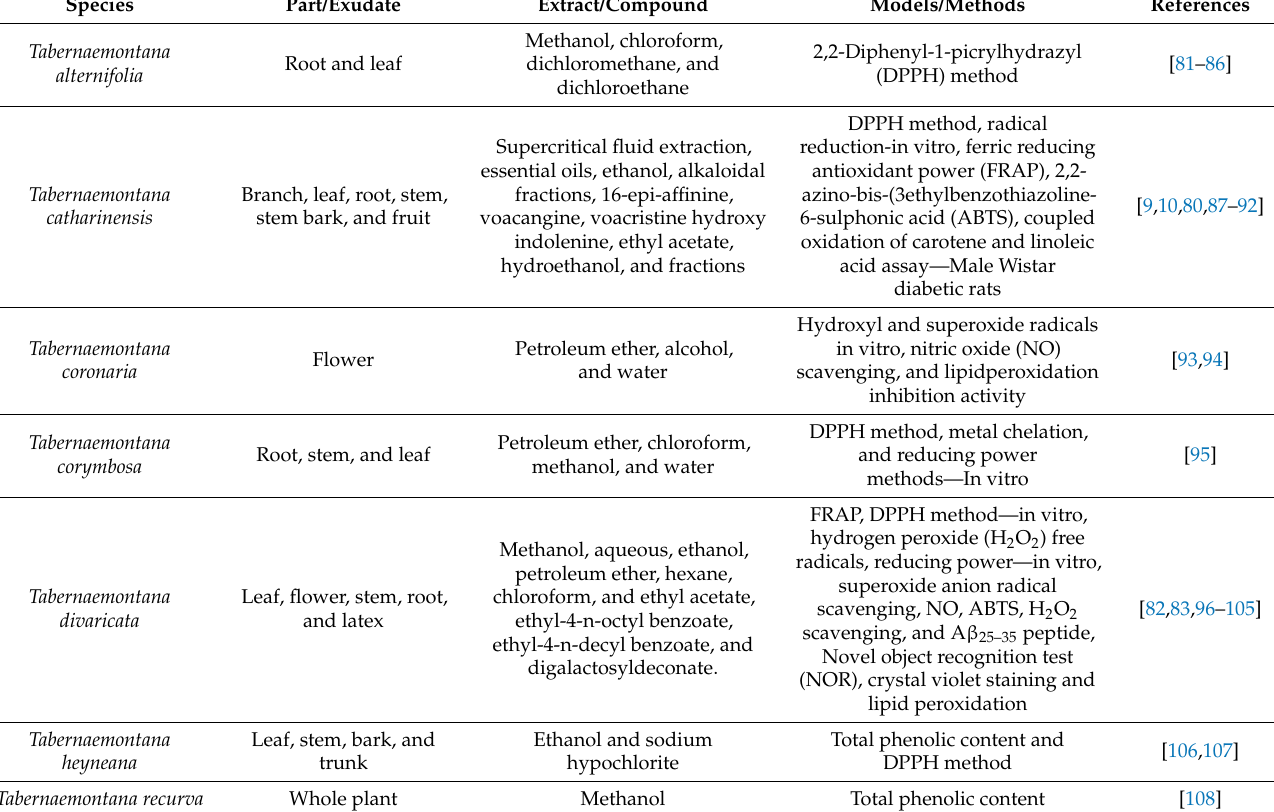
Table 2. Antioxidant activities of extracts and compounds isolated from Tabernaemontana species.